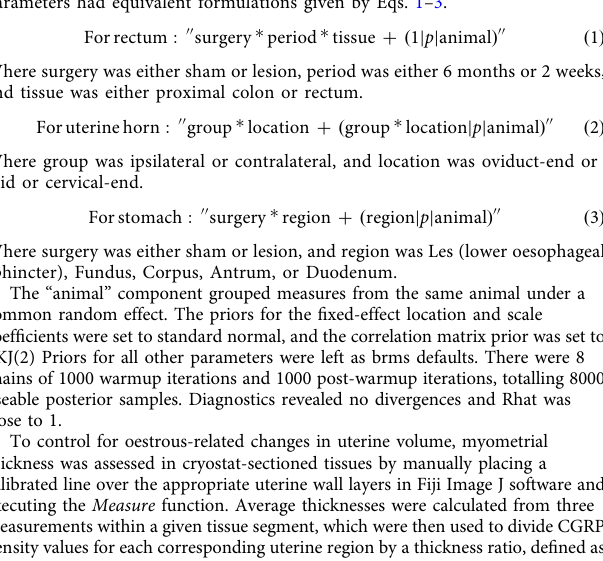
Fig. 9 Depletion of spinal afferent neuropeptide CGRP, after DRG removal. a CGRP immuno fl uorescence in distal colons from control (sham) mice and from mice lacking bilateral L5-S1 DRG, both 2 weeks after surgery. Intensely CGRP-immuno fl uorescent axons are prominent in mouse colorectum, characteristic of spinal afferent nerves. Less intense CGRP immuno fl uorescence occurs in a subclass of enteric neuron. Whilst intense CGRP labelling was abolished by the LS lesion, CGRP was still detectable in enteric neurons. This is consistent with selective ablation of spinal afferent neurons from the colon in LS lesioned animals. b Summary of CGRP immunohistochemical results in both short (2-week post surgery) and long term (6 months post) mice. Here, posterior densities (vertical axis) represent probability distributions of the proportion CGRP immunoreactivity. The black dot below the centre of a distribution represents the mean and the horizontal black lines either side of the dot, from thickest to thinnest, represent the 50, 95 and 99.5% con fi dence intervals. CGRP immunoreactivity is quanti fi ed as the proportion (%) positive pixels per immuno fl uorescence micrograph. The results show signi fi cant reductions in CGRP immuno fl uorescence in the distal, but not proximal colon in both types of lesioned mice compared to their controls. This suggests the ablation of spinal afferent neurons is stable over long periods of time in the rectum. The spatial pattern of CGRP depletion is consistent with the known distribution of LS afferent neurons that enter the colorectum via pelvic/rectal nerve pathways. Coloured dots below the posterior densities represent individual animal averages. Identically coloured dots in horizontally adjacent graphs represent values from the same animal. The same data are presented below the panel of posterior densities as standard graphs, showing mean ± SD and individual markers for each animal average. c Representative micrographs showing CGRP immuno fl uorescence in uterine horn following unilateral removal of T13-L2 DRG. d Quantitative summary of CGRP immuno fl uorescence in the uterine horns. Ipsilateral CGRP density was signi fi cantly decreased relative to the contralateral horn in all subregions sampled. Posterior densities have the same de fi nitions as described in (b) and coloured dots represent replicate measures (identical colours represent values from the same animal). The same data are also presented adjacent the panel of posterior densities as standard graphs, showing mean ± SD and individual markers for each animal